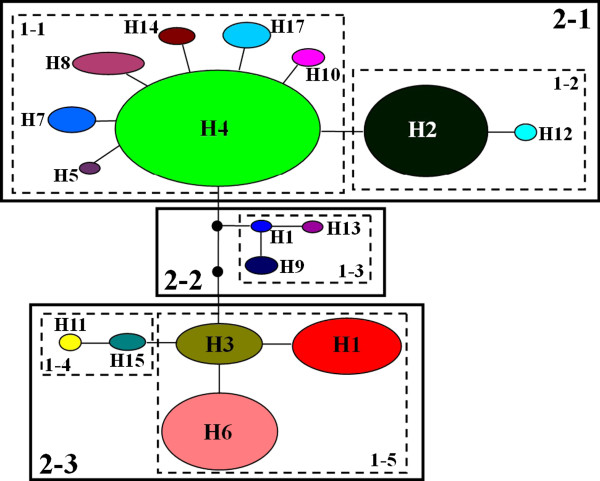
Nested cladogram of 17 nrDNA haplotypes across the 21 C. taliensis populations.  Circles in colors denote different haplotypes, and the size of each circle is proportional to that haplotype frequency across populations. Each branch between the haplotypes represents a mutational step. The dotted lines indicate independent mutation events converging on a shared haplotype. The squared loops show the nested clades or haplotypes in the network, which were resolved by nested clade phylogeographic analysis (NCPA).